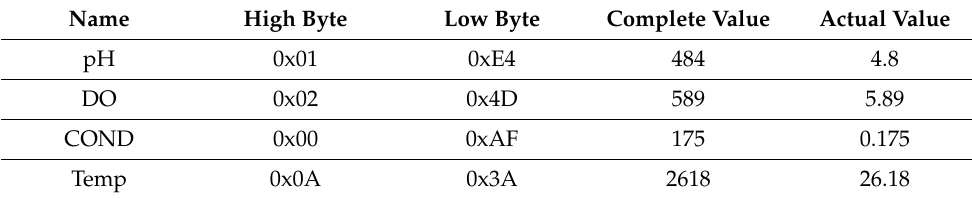
Table A2. The data format sending from Water quality Sensor (CWQ-Y4000).